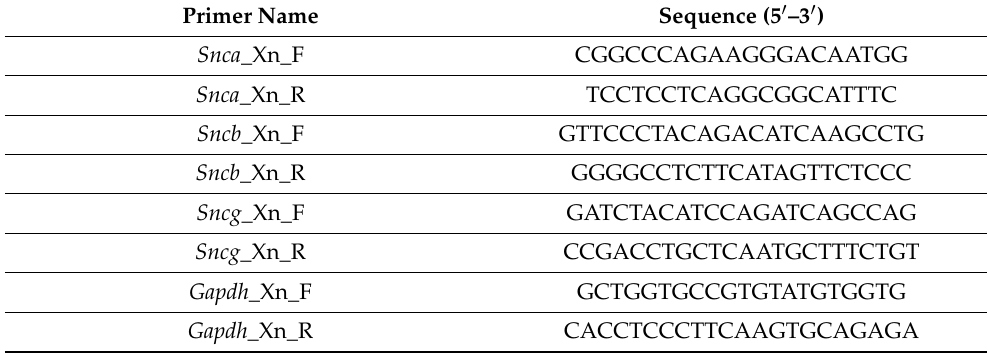
Table 2. Oligonucleotide sequences used as qPCR primers for the analysis of syn transcripts.